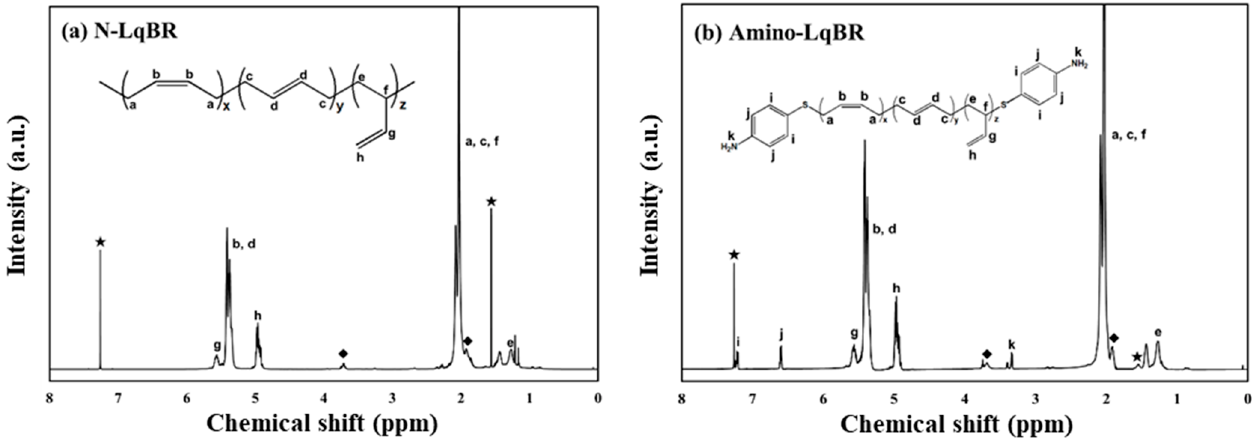
Figure 2. 1 H NMR spectra; ( a ) N-LqBR; ( b ) amino-LqBR ( ★ CDCl 3 solvent, ◆ THF solvent).